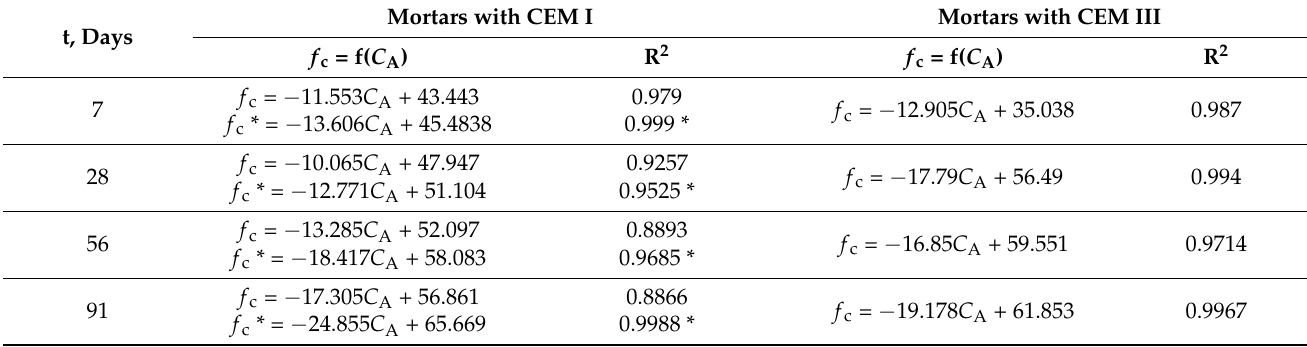
Table 5. Dependence of compressive strength on the amount of admixture containing aluminum powder and type of cement. Mortars with CEM I Mortars with CEM t, Days